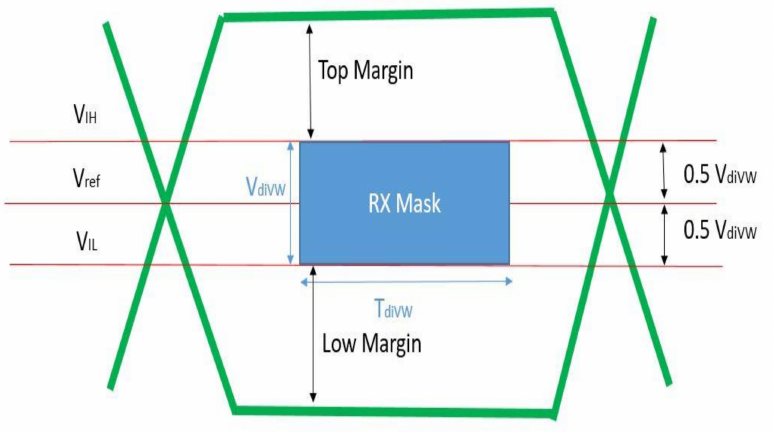
Figure 5. DDR4 data eye showing receiver RX mask, eye width, top and low